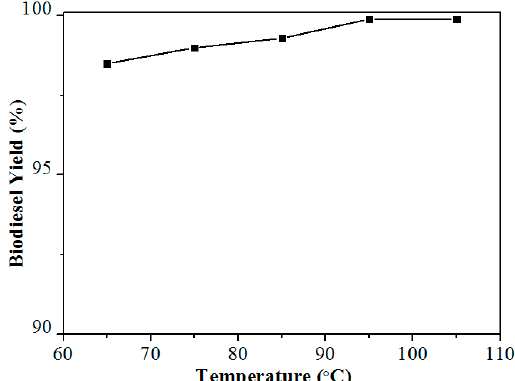
Figure 7. Biodiesel yields obtained from Firmiana platanifolia L.f. oil catalyzed by Ca-B(700) at different temperatures of 65–105 °C. Reaction conditions: Catalyst dosage 4 wt%, the molar ratio of alcohol to oil 20:1, and the reaction time of 2 h.